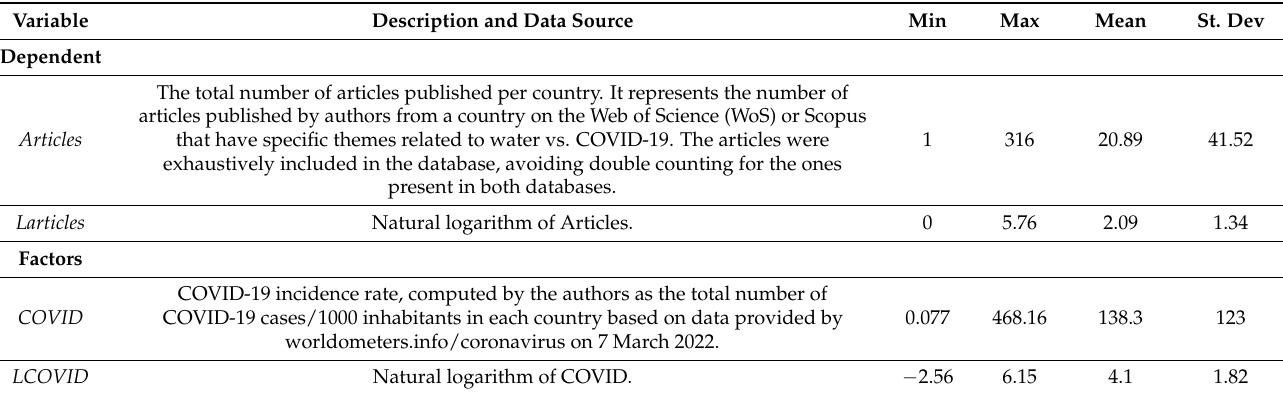
Table 1. Variables used in the